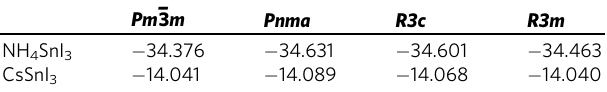
Table 3 The total energy/f.u. (in eV) of NH 4 SnI 3 and CsSnI 3 relaxed from initial structures